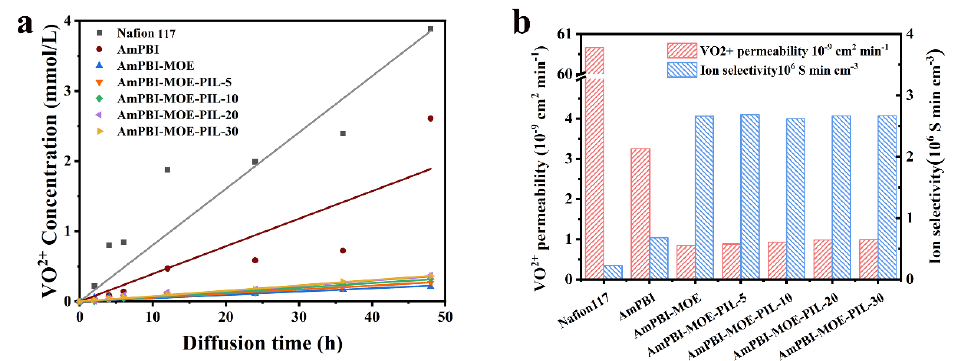
Figure 3. Vanadium concentration curve ( a ) and ion selectivity ( b ) of AmPBI, AmPBI-MOE-PIL-X membranes, and Nafion117.